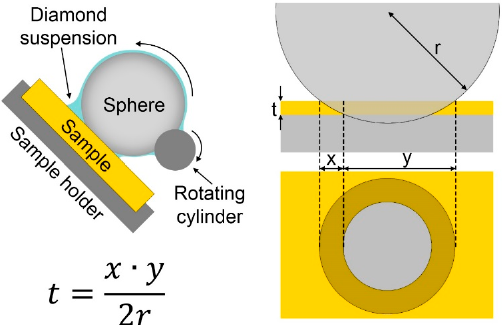
Figure 6. Experimental setup, working functionality and equation to calculate the film thickness ( t ) with a Calo tester; r is the radius of the sphere; x is the difference between the radius of the crater and radius of the part of the crater at the bottom of the coating; y is diameter of the crater from which it is subtracted x .